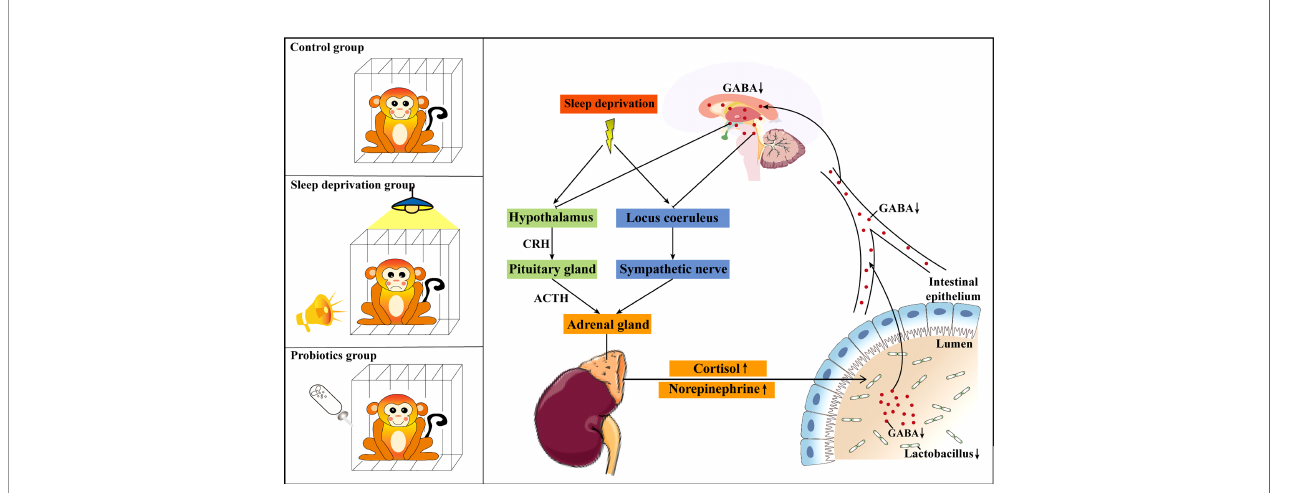
FIGURE 8 | Schematic diagram of the possible mechanism of Lactobacillus ameliorating sleep deprivation (SD)-induced stress responses and gut dysbiosis. Lactobacillus alleviated SD-induced stress responses and gut dysbiosis by increasing the absorption of gut-derived GABA. CRH, corticotropin-releasing hormone; ACTH, adrenocorticotropic